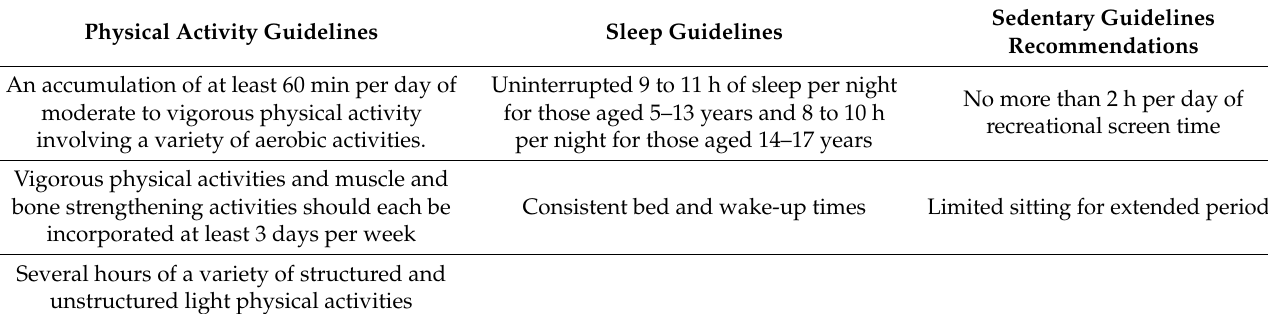
Table 1. Contents of